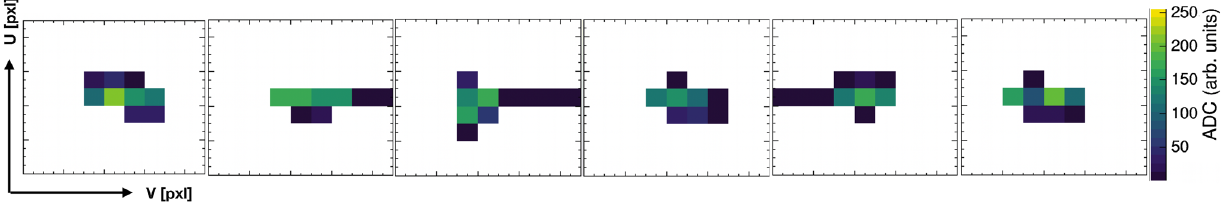
Fig. 2 Example clusters of simulated magnetic monopoles from the inner region of the PXD (pixel dimensions: 50 µ m × 55 µ m). The seed pixel is located at the centre of the 9 × 9 pixel matrix. The colour scale represents the single-pixel charge in ADC